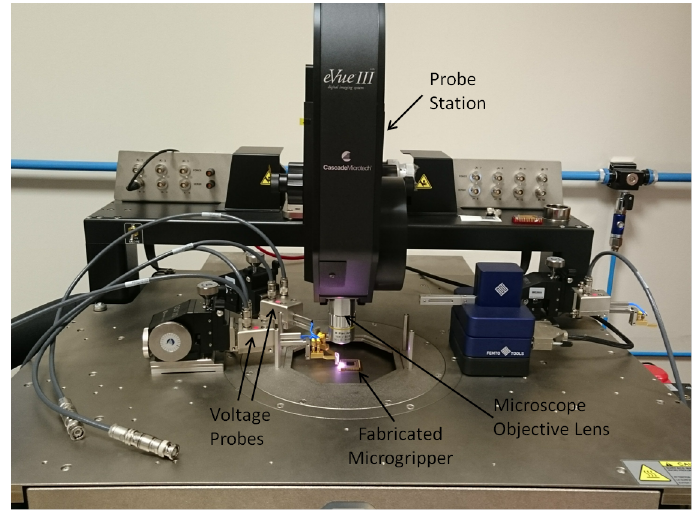
Figure 10. The fabricated microgripper enclosed in an integrated circuit (IC) package and mounted on the platform of the vibration isolation Cascade Microtech probe station with voltage probes to actuate the microgripper